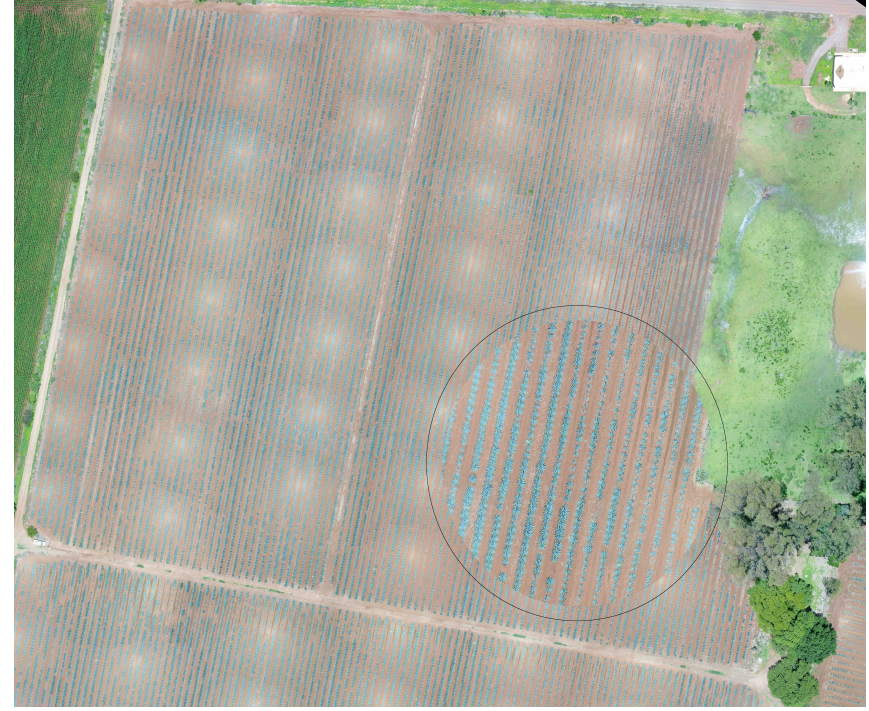
Figure 5. Agave plantation: the zone surrounded by a circle zooms in on the lines of the sowing